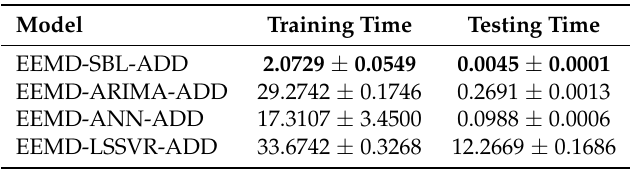
Table 13. Running time (in seconds) of the models.